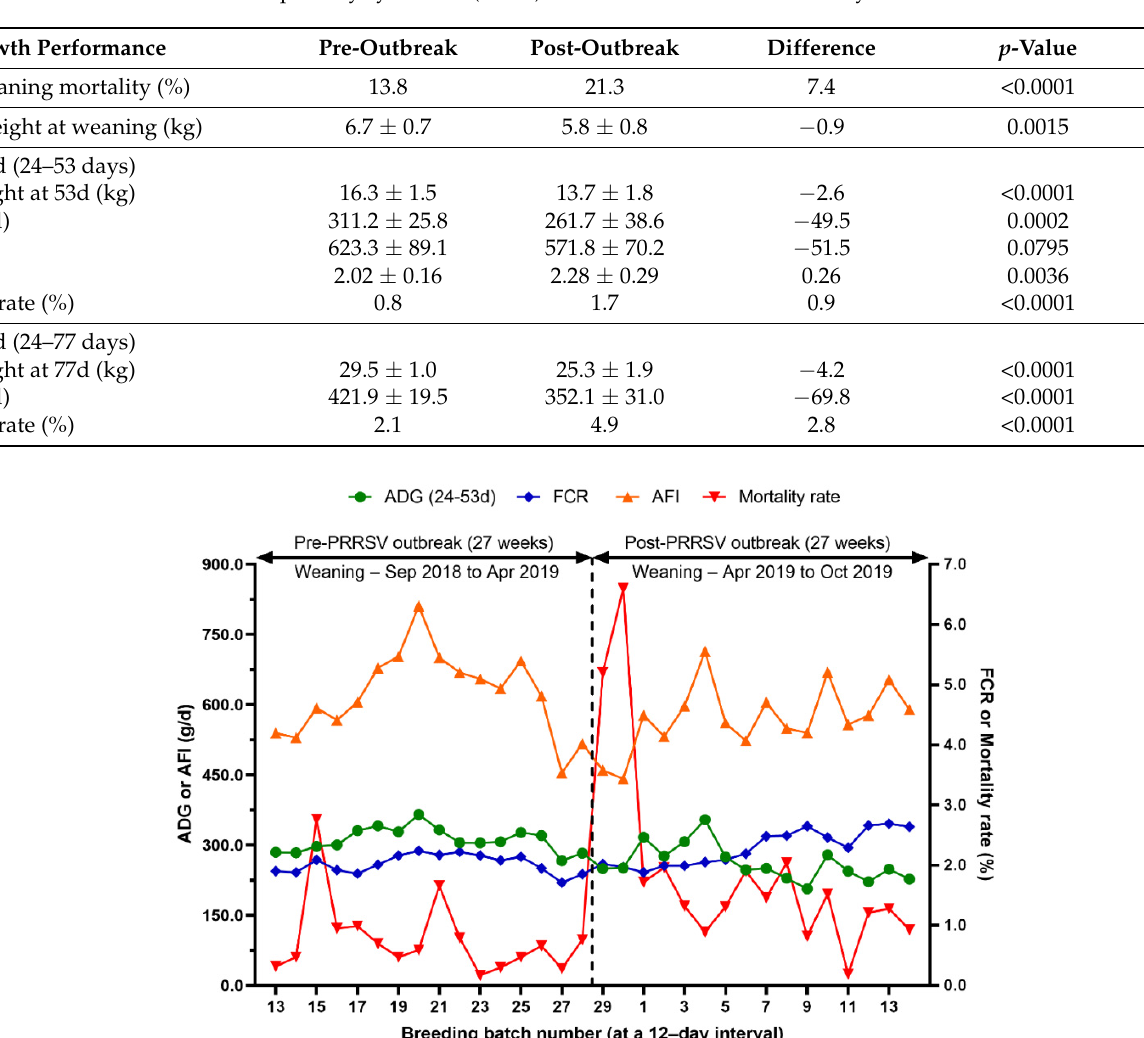
Table 2. Comparison of the growth performance of nursery pigs before and after a porcine reproduc- tive and respiratory syndrome (PRRS) outbreak on a farrow-to-nursery farm.